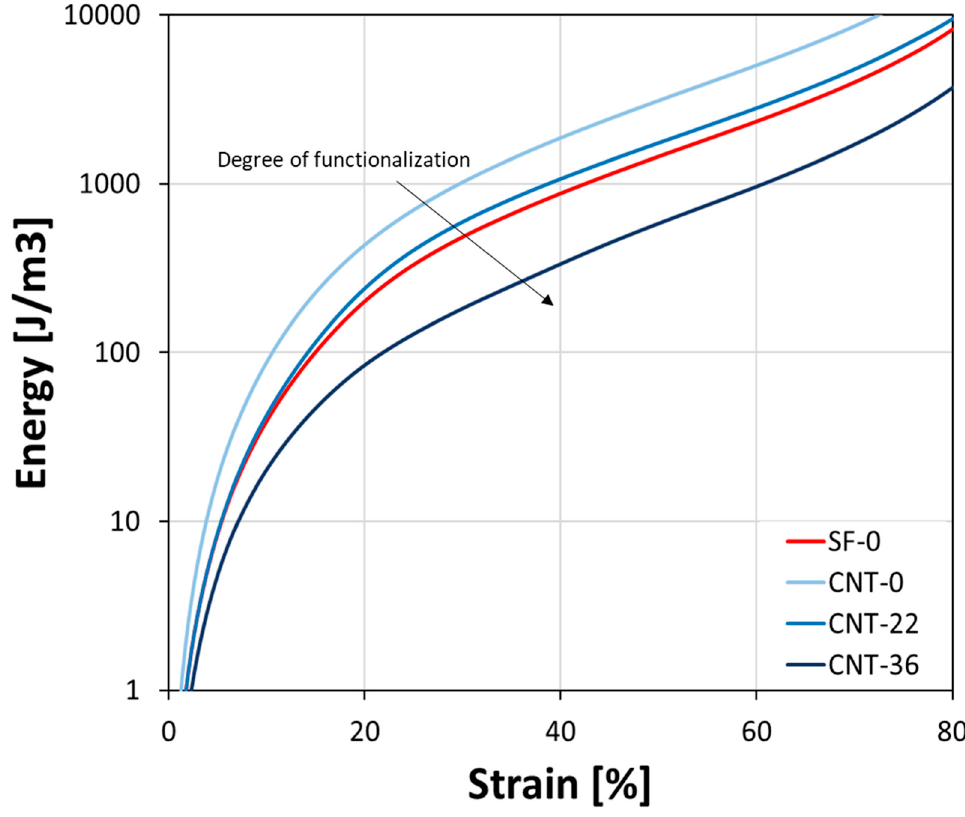
Figure 8. Compressive energy plot of composite foams.